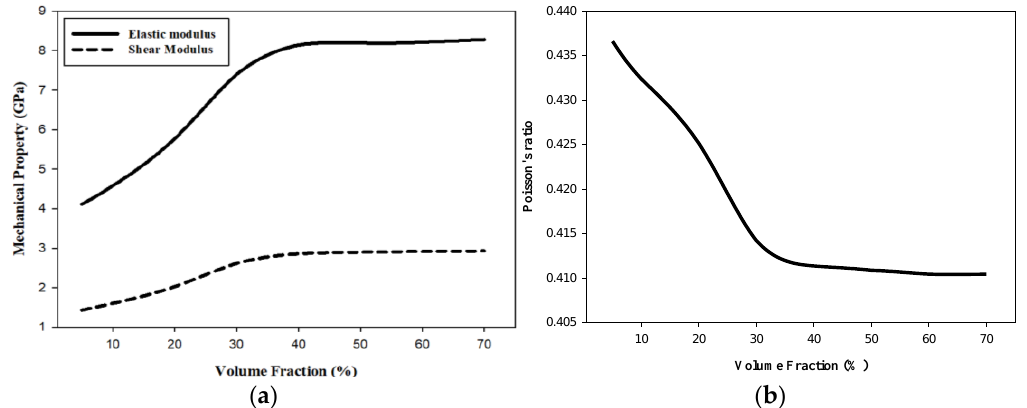
Figure 4. FEM predictions of mechanical properties of composites as a function of the VF. ( a ) Elastic and shear moduli and ( b ) Poisson’s ratio. Table 3. FEM predictions of elastic modulus, shear modulus, and Poisson’s ratio.